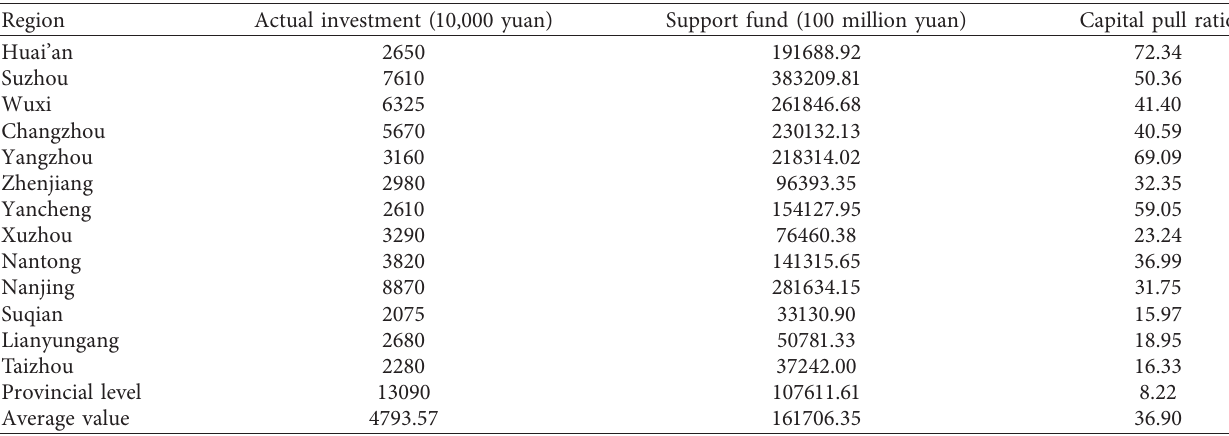
Table 4: Multiplier effect of special funds in Jiangsu Province from 2011 to